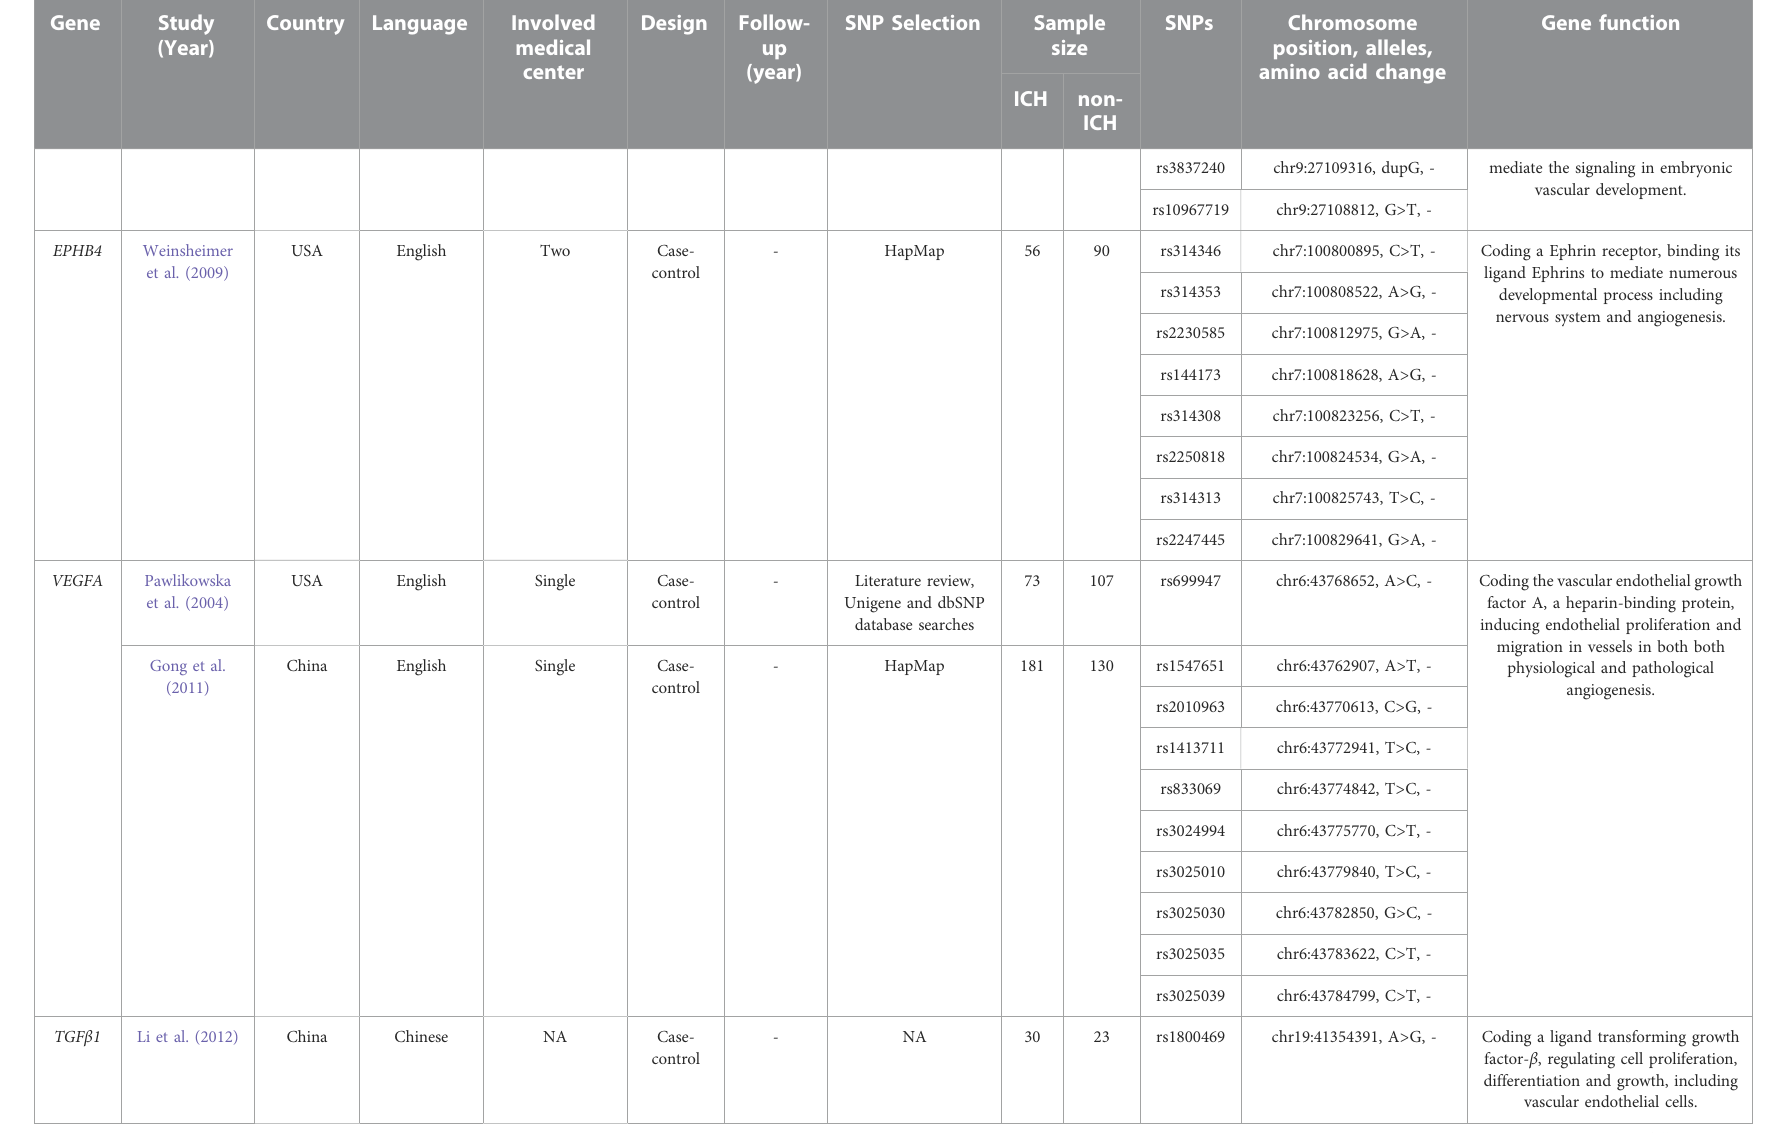
TABLE 1 ( Continued ) Summary of the included genetic studies on brain arteriovenous malformation related